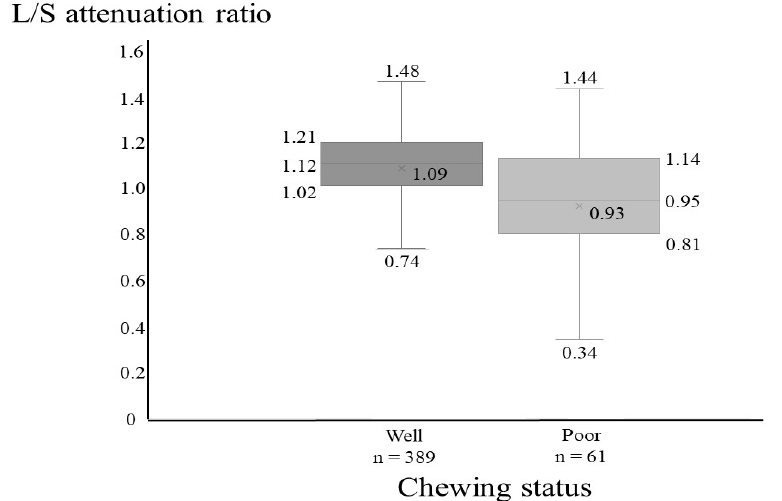
Figure 1. Relationship between L/S attenuation ratio and chewing status. Abbreviations: L/S attenuation ratio, liver/spleen attenuation ratio. p < 0.001, Mann–Whitney U -test.